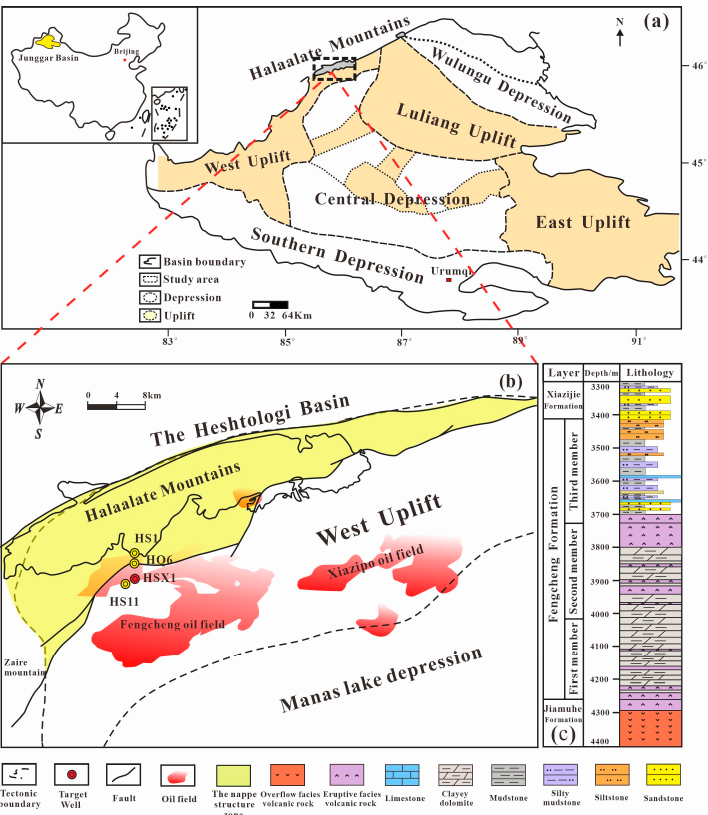
Figure 1. Regional tectonic location of Hashan area and the stratigraphic column of the Permian Fengcheng Formation: ( a ) Location of the Junggar Basin within China. ( b ) Tectonic location of Hashan area in northwestern margin of Junggar Basin. ( c ) lithostratigraphic column of Permian Fengcheng Formation of well